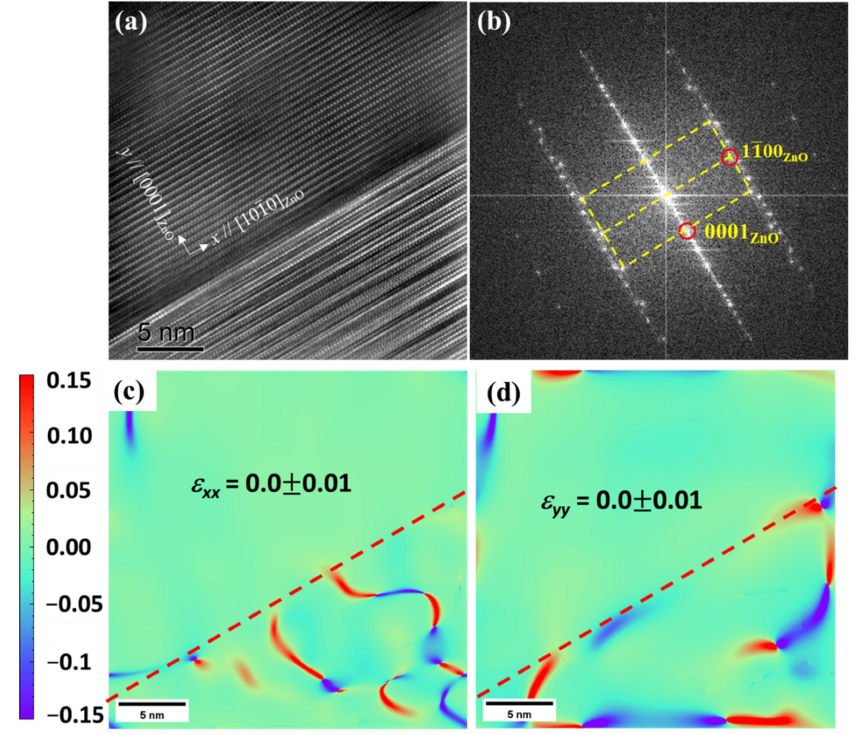
Figure 7. ( a ) HRTEM image of the region adjacent to the interface between the ZnO layer and the mica substrate viewed along the ZnO [1120] zone axis. ( b ) Corresponding FFT pattern of ( a ). The 1100 and 0001 reflections of the ZnO were chosen to implement geometric phase analysis. The GPA strain maps of strain components ( c ) ε xx and ( d ) ε yy obtained from the region adjacent to the interface. The red-dashed lines indicate the